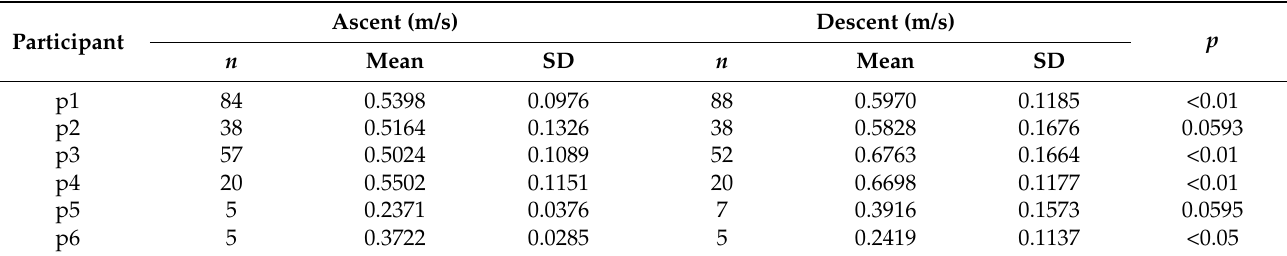
Figure 7. Comparison of the descent speed between participants. Blue circles and error bars indi- cate the mean values and standard deviations. respectively. 3.2. Handrail Grasping Ratio and Grasping Area From the handrail grasping ratios shown in Tables 4 and 5 and the handrail grasping area visualized in Figure 8, p1, a male in his 20s, showed the smallest handrail grasping ratio when ascending and descending stairs in Environment 1. Therefore, p1 almost en- tirely ascended and descended the stairs without using a handrail, indicating that he is not dependent on a handrail. Second, p3, a male in his 50s, was less dependent on the handrail, and his handrail grasping ratio tended to increase slightly when descending. P4, who is in her 20s, held the handrail more while ascending than while descending. How- ever, her handrail grasping position was concentrated locally, which indicates her prefer- ence for using the handrail. Furthermore, p2, who is in her 50s, held the handrail the most among the participants in Environment 1, both when ascending and descending. The grasping ratio increased approximately twice as much when descending, and the grasp- ing positions were evenly distributed throughout the handrail, indicating an increase in handrail dependence. The handrail grasping ratios of p5–p6 in their 70s in Environment 2 were generally higher than those of the participants in their 20s (p1, p4) and 50s (p2, p3) in Environment 1. Furthermore, p5 and p6 grasped the handrail for approximately 80% of the time when ascending, and almost all areas of the handrail were red, indicating that they were signif- icantly dependent on the handrail when ascending the stairs. When descending the stairs,